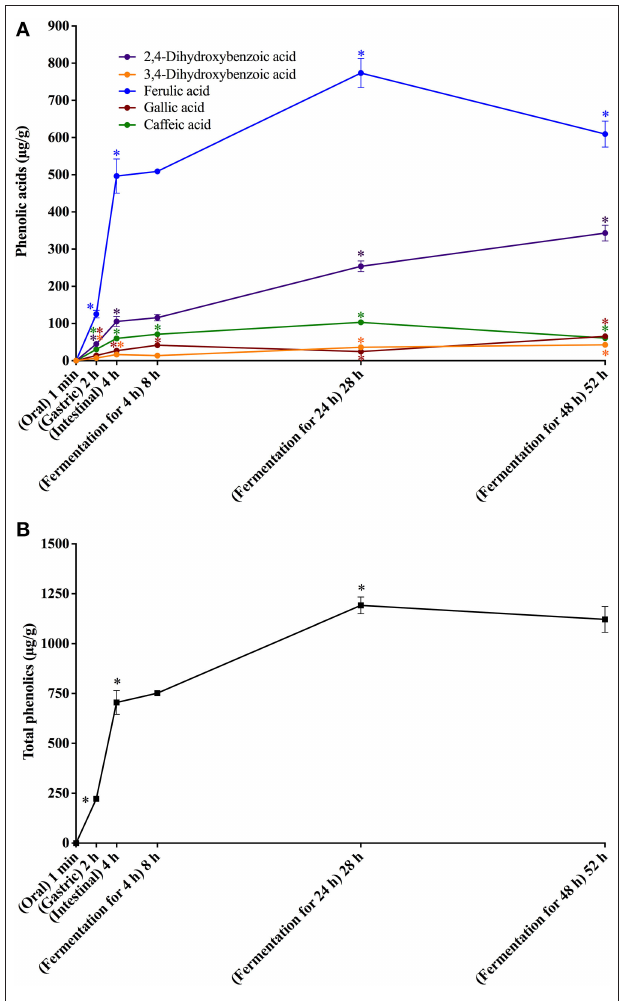
FIGURE 5 | Bioaccessibility of total free (A) and total melanoidin-bound (B) phenolics from coffee and bread expressed as the percentage of compounds released during the simulated digestion and gut fermentation stages in relation to the total phenolics content in the corresponding